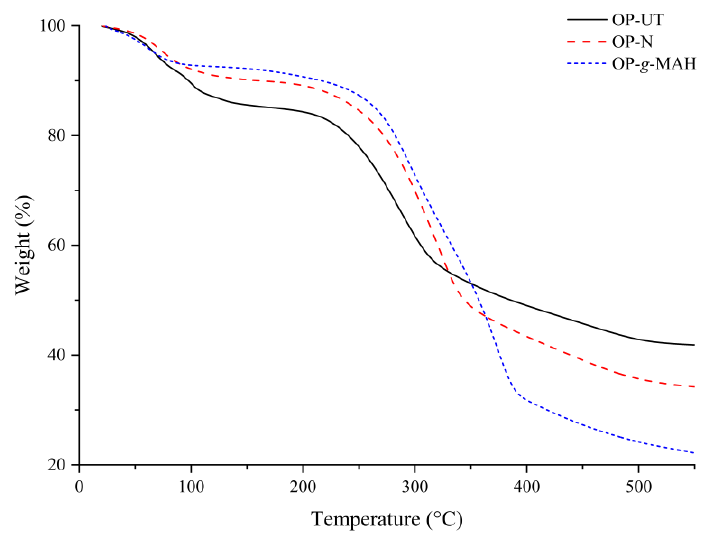
Figure 9. TGA curves of OP-UT, OP-T and (OP-T)- g -MAH.